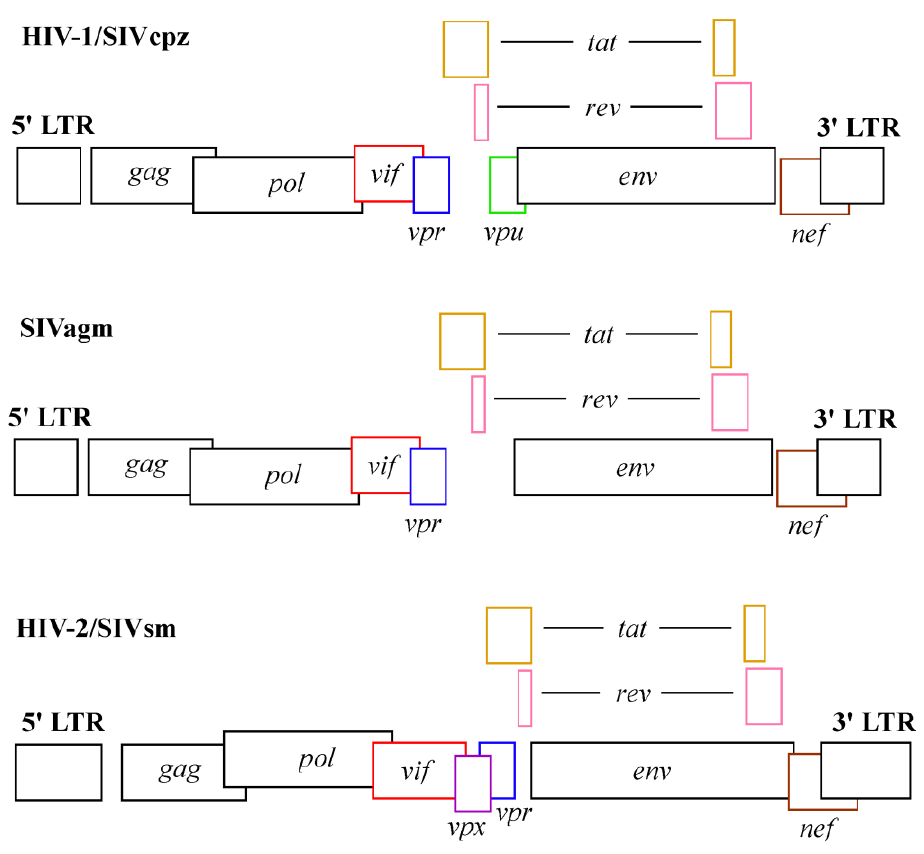
Figure 1. Genomic organization of HIV-1/SIVcpz, SIVagm and HIV-2/SIVsm [32]. HIV-1 contains the vpu accessory gene, but not the vpx accessory gene. HIV-2 and SIVsm encode vpx but not vpu . SIVagm encodes neither vpu nor vpx